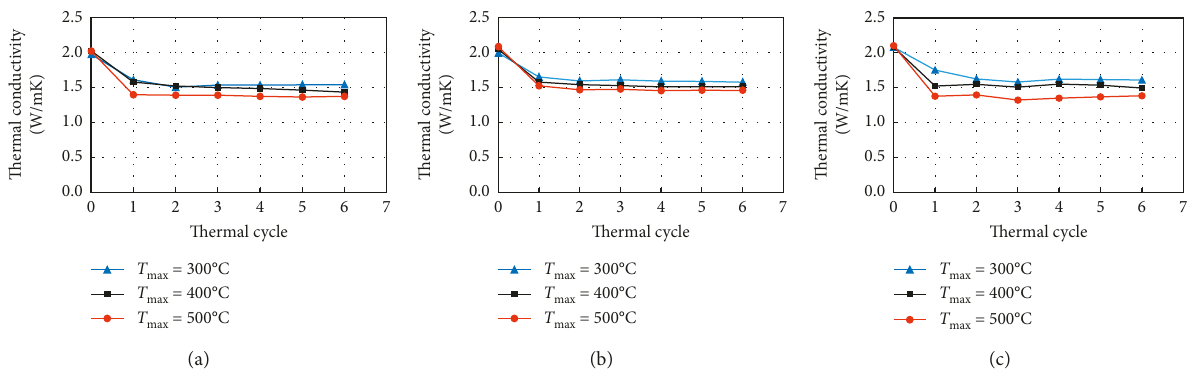
Figure 10: Variations in thermal conductivity during thermal cycling at different maximum temperatures. (a) Steel fiber content � 1.0%. (b) Steel fiber content � 1.5%. (c) Steel fiber content � 2.0%.